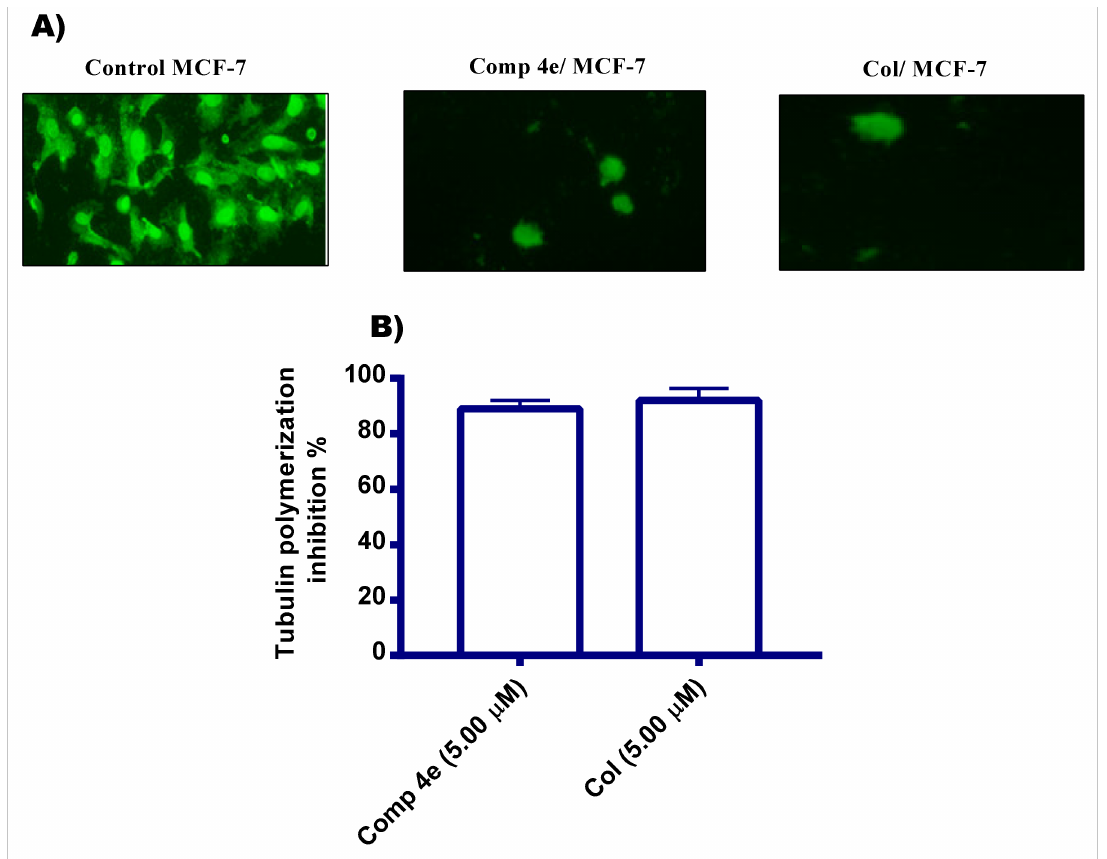
Figure 3. ( A ) Immunofluorescence intensity of tubulin localization in MCF-7 cells after treatment with compound 4e and Col compared with untreated control cells. ( B ) Tubulin inhibition percentage (%) compared to